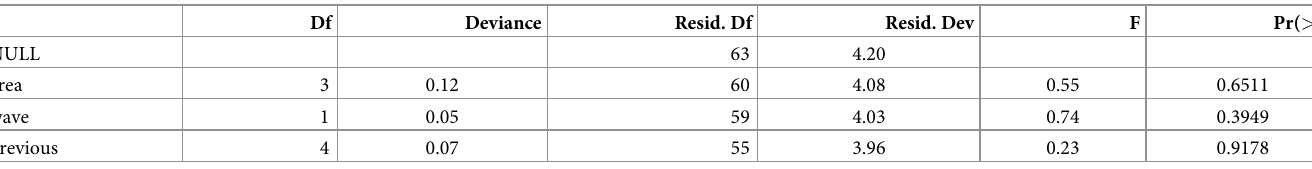
Table 11. ANOVA table for